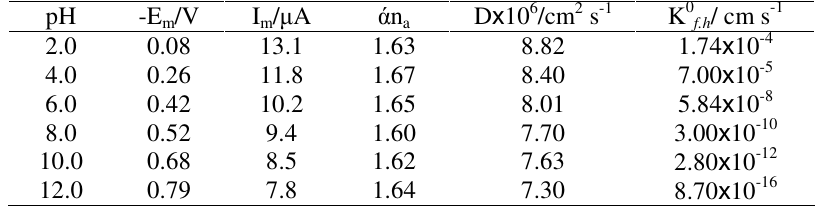
Table 4. Typical differential pulse polarographic data of fluchloralin concentration 0.5 mM, Drop time: 3s, Pulse amplitude: 50